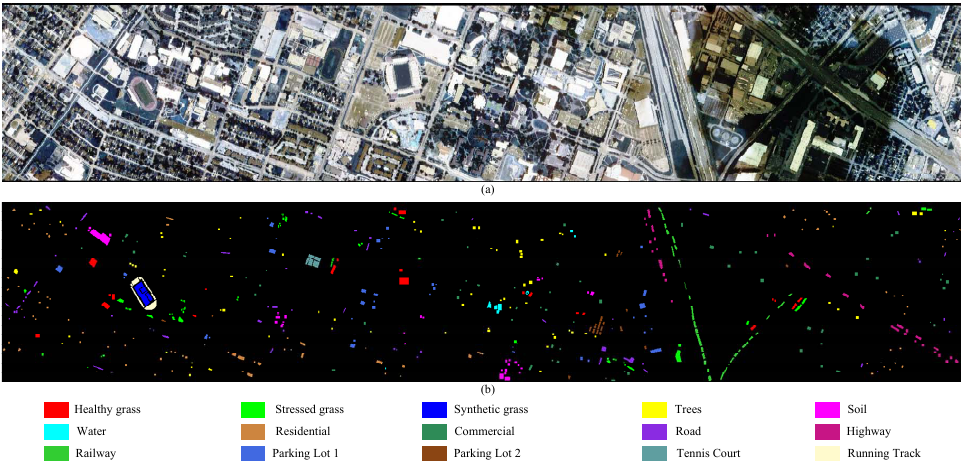
Figure 6. The false-color image ( a ) and the ground truth ( b ) for the UH